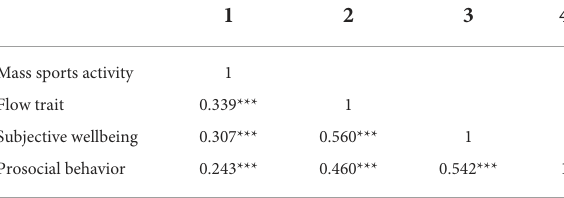
TABLE 2 Matrix of Pearson correlation coefficient for